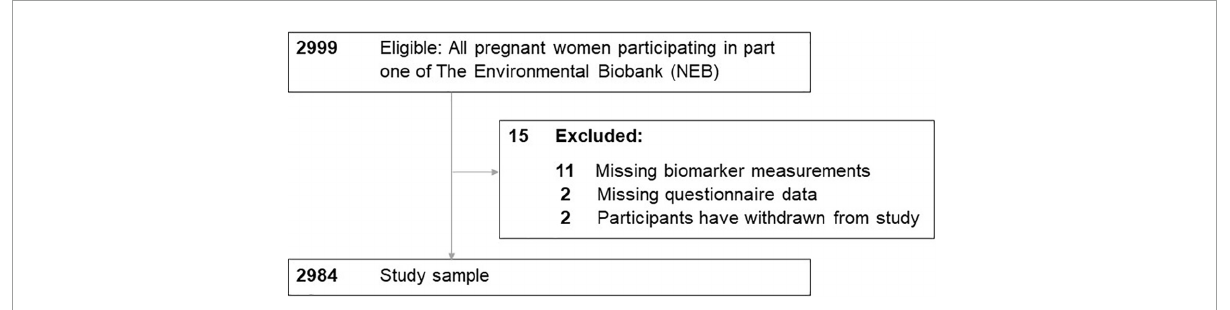
FIGURE1 Inclusion of participants in the study sample. The Norwegian Environmental Biobank is a sub-study of the Norwegian Mother, Father, and Child Cohort Study (MoBa), including women who were pregnant in 2002–2008.